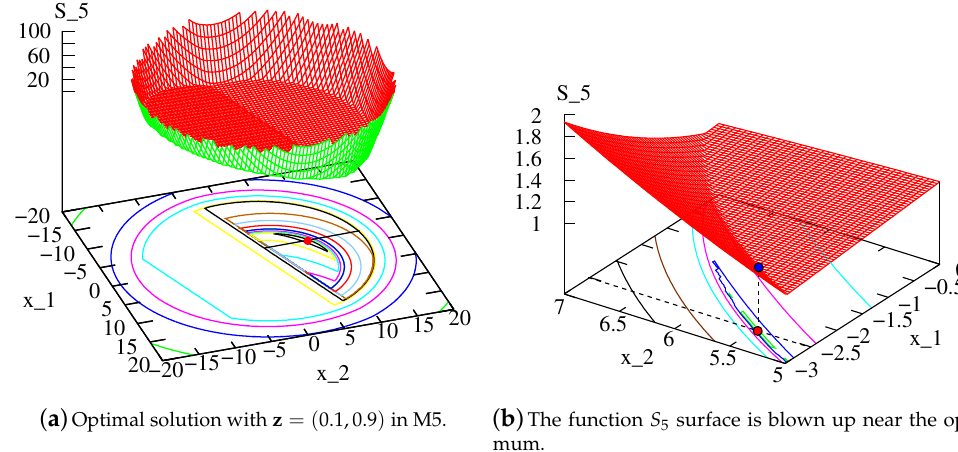
Figure 4. In-fill solution for a specific z -vector to be obtained by framework M5 for SRN